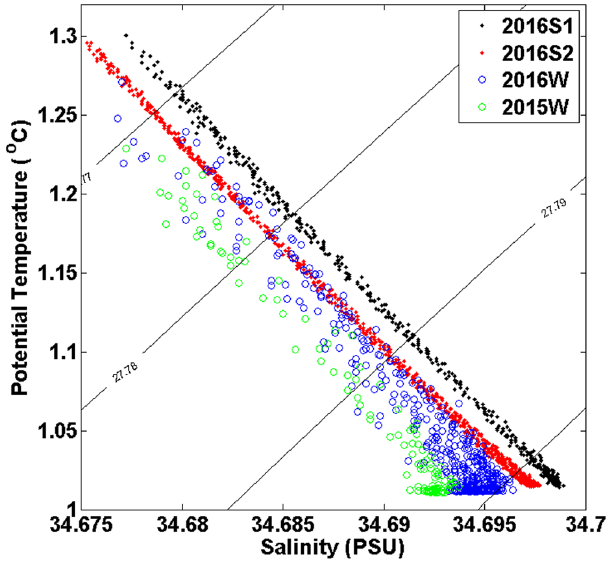
Figure 4. θ -S scatter diagram of the four observations. The black dots, red dots, blue circles, and green circles represent 2016S1, 2016S2, 2016W, and 2015W, respectively. Figures were plotted using